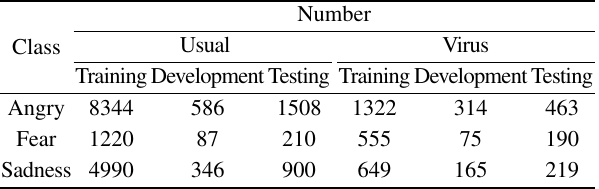
Table 1 Number distribution of each negative emotion class on SMP.